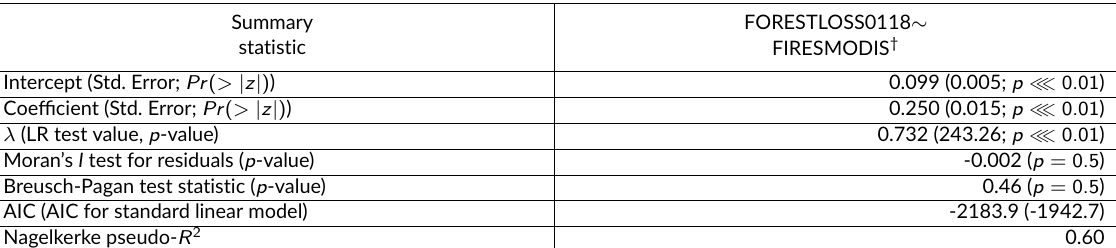
Table 2 – Spatial error model fitting results of forest loss as a function of fire density for the 2001-2018 period (MODIS fire